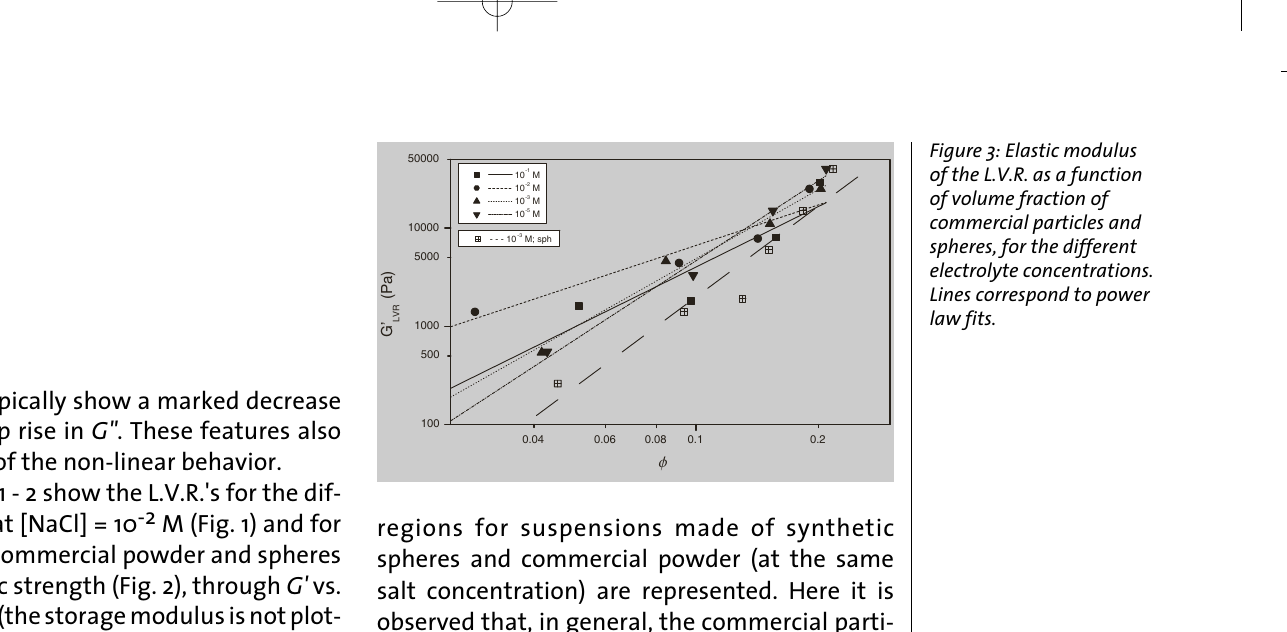
Figure 3: Elastic modulus of the L.V.R. as a function of volume fraction of commercial particles and spheres, for the different electrolyte concentrations. Lines correspond to power law fits.